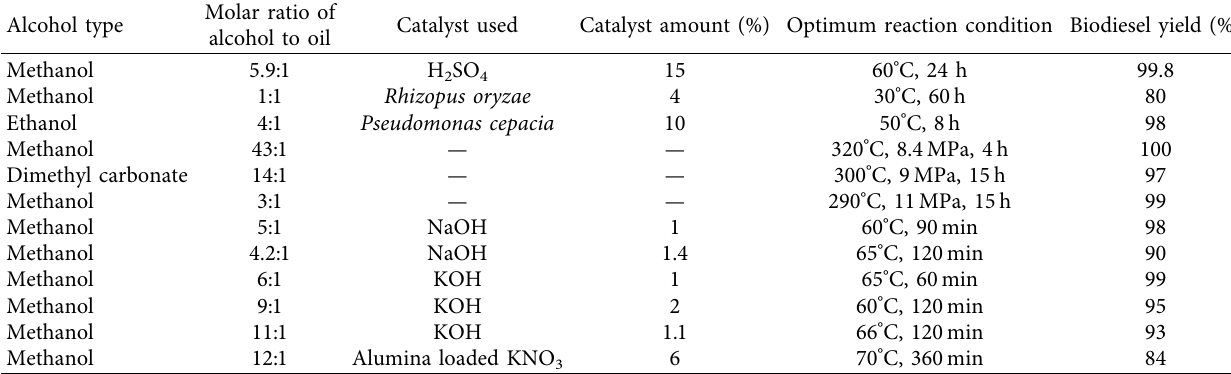
Table 6: Catalyzed transesterification of vegetable oils with optimized reaction variables [56].